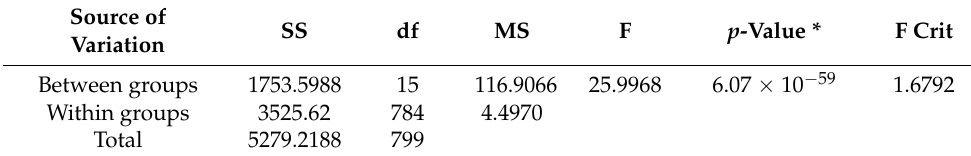
Table 7. Source of variation ANOVA. Source